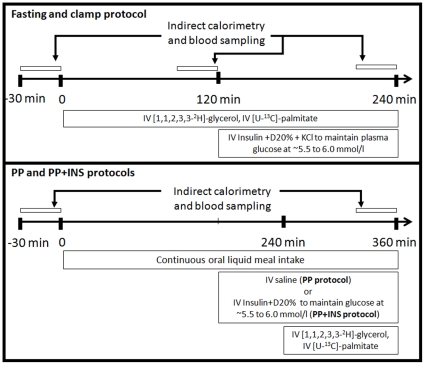
Experimental protocols.Each participant underwent three experimental protocols. The first protocol consisted, first, of a two-hour fasting experimental phase (time 0 to 120 min) followed by a two-hour normoglycemic hyperinsulinemic clamp (time 120 to 240 min) with determination of plasma glycerol and NEFA metabolism using stable isotopic tracers. The second protocol (postprandial or PP protocol) consisted in a 6-hour continuous oral intake of a standard liquid meal with determination of steady-state postprandial glycerol and NEFA metabolism using stable isotopic tracers. The third protocol (postprandial with exogenous insulin infusion or PP+INS protocol) was identical to the second protocol with the exception of intravenous insulin and dextrose infusion in the last 3 hours of the postprandial experiment to maintain normoglycemia (∼5.5 to 6.0 mmol/l) in all participants.